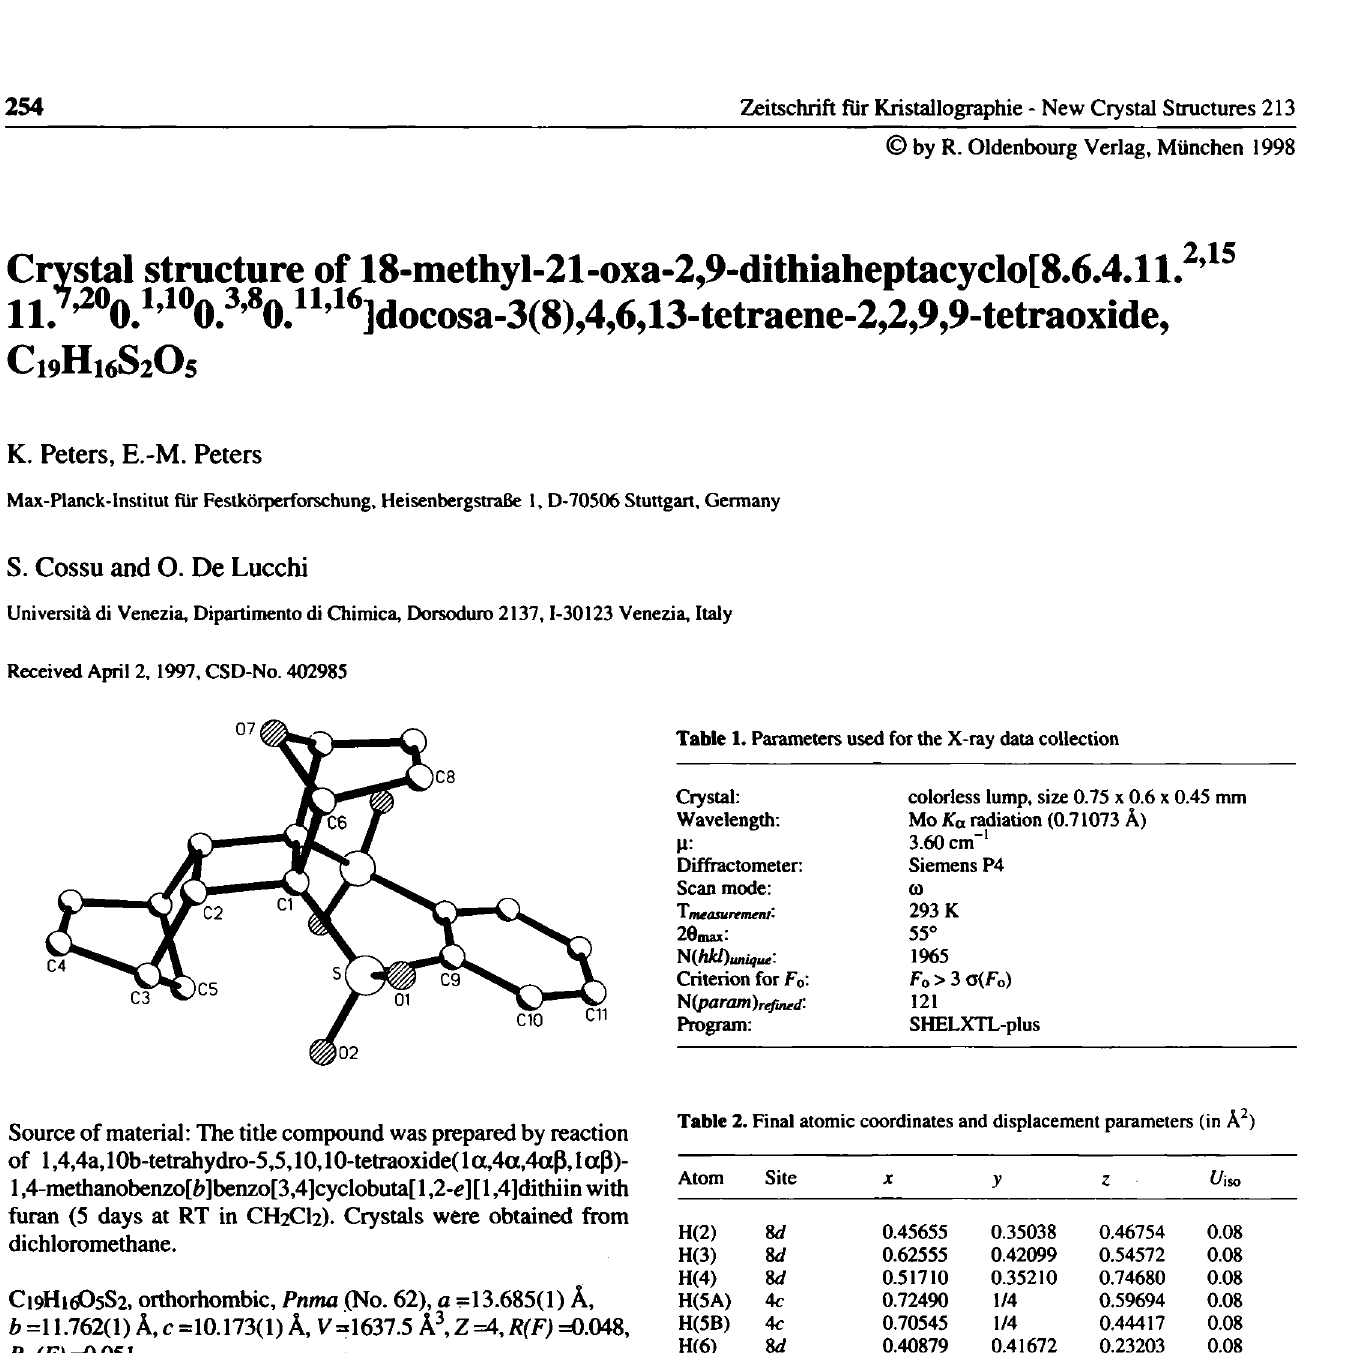
Table 3. Final atomic coordinates and displacement parameters (in Â^)